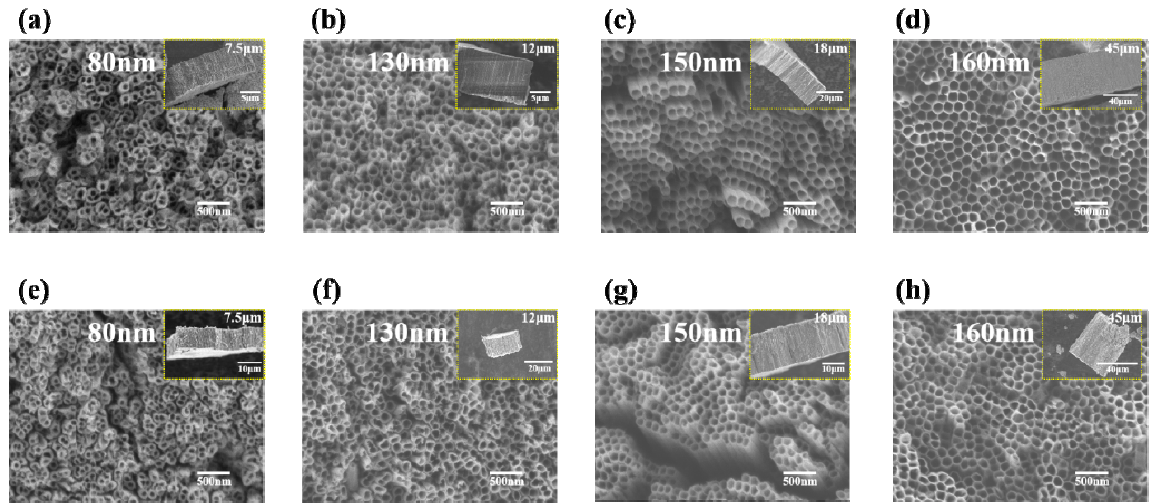
Figure 6. SEM images of top view of TiO 2 nanotube arrays before ( a – d ) and after ( e – h ) annealing with different oxidation times in electrolyte with 0.5 wt% NH 4 F: ( a , e ) 2 h; ( b , f ) 5 h; ( c , g ) 10 h; ( d , h ) 20 h. Inserts show side view of TiO 2 nanotube arrays.